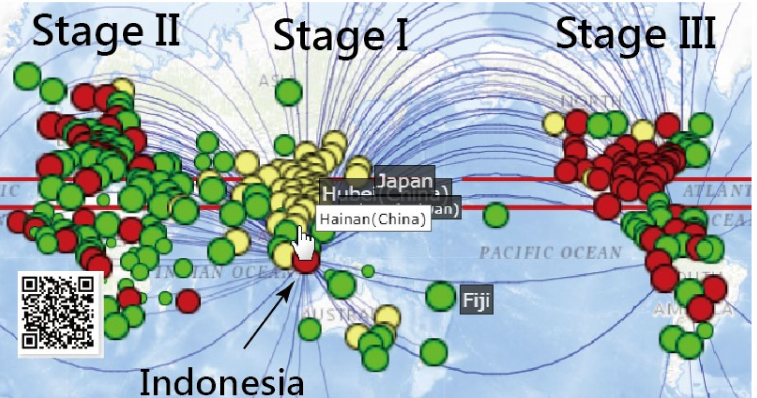
Figure 3. Indonesia compared to three clusters separated by social network analysis (SNA) using the correlation pattern across three stages in yellow, green, and red, respectively. (Note: the curve means the close relation (correlation coefficient (CC) > 0.8) between two countries/regions according to SNA guidelines (Note: readers are invited to scan the QR-code to examine the detail on a dashboard)).